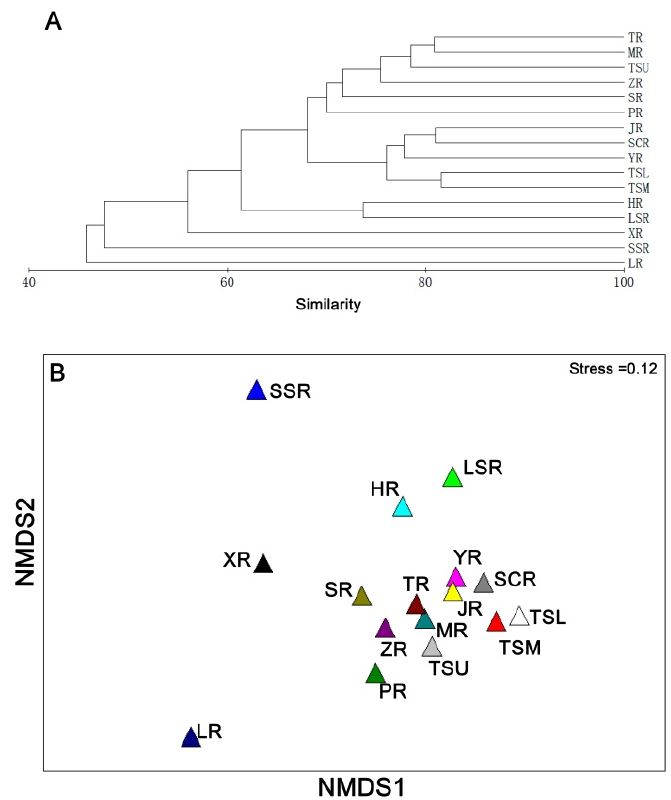
Figure 3. Dendrogram from a hierarchical cluster analysis of species composition ( A ) and non-metric multidimensional scaling (NMDS) ordination ( B ) of community composition in the Gan River Basin for the current period. River codes are the same as in Table 1.